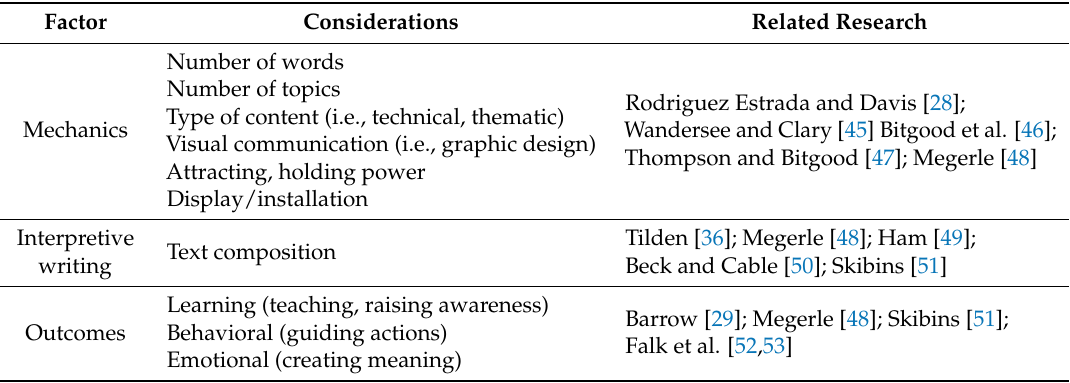
Table 1. Primary practical factors involved in sign